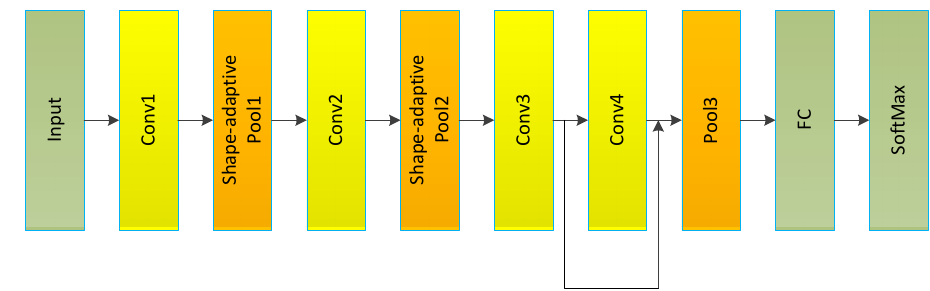
Figure 5. Diagram of proposed shape-adaptive CNN (SAE-CNN) structure. Table 1. Details of the proposed shape-adaptive CNN (SAE-CNN)